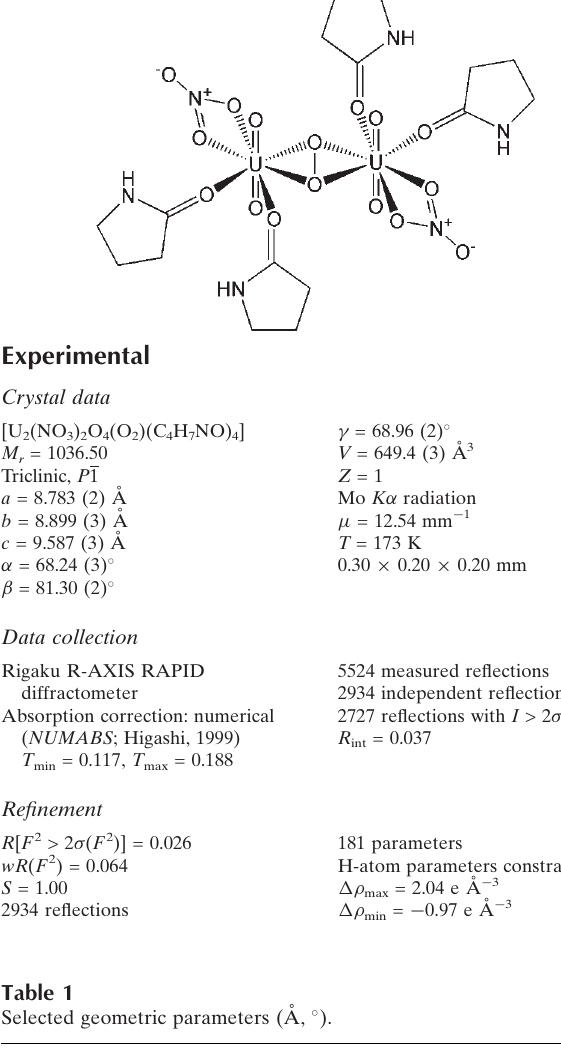
Selected geometric parameters (A˚ , (cid:2) ).